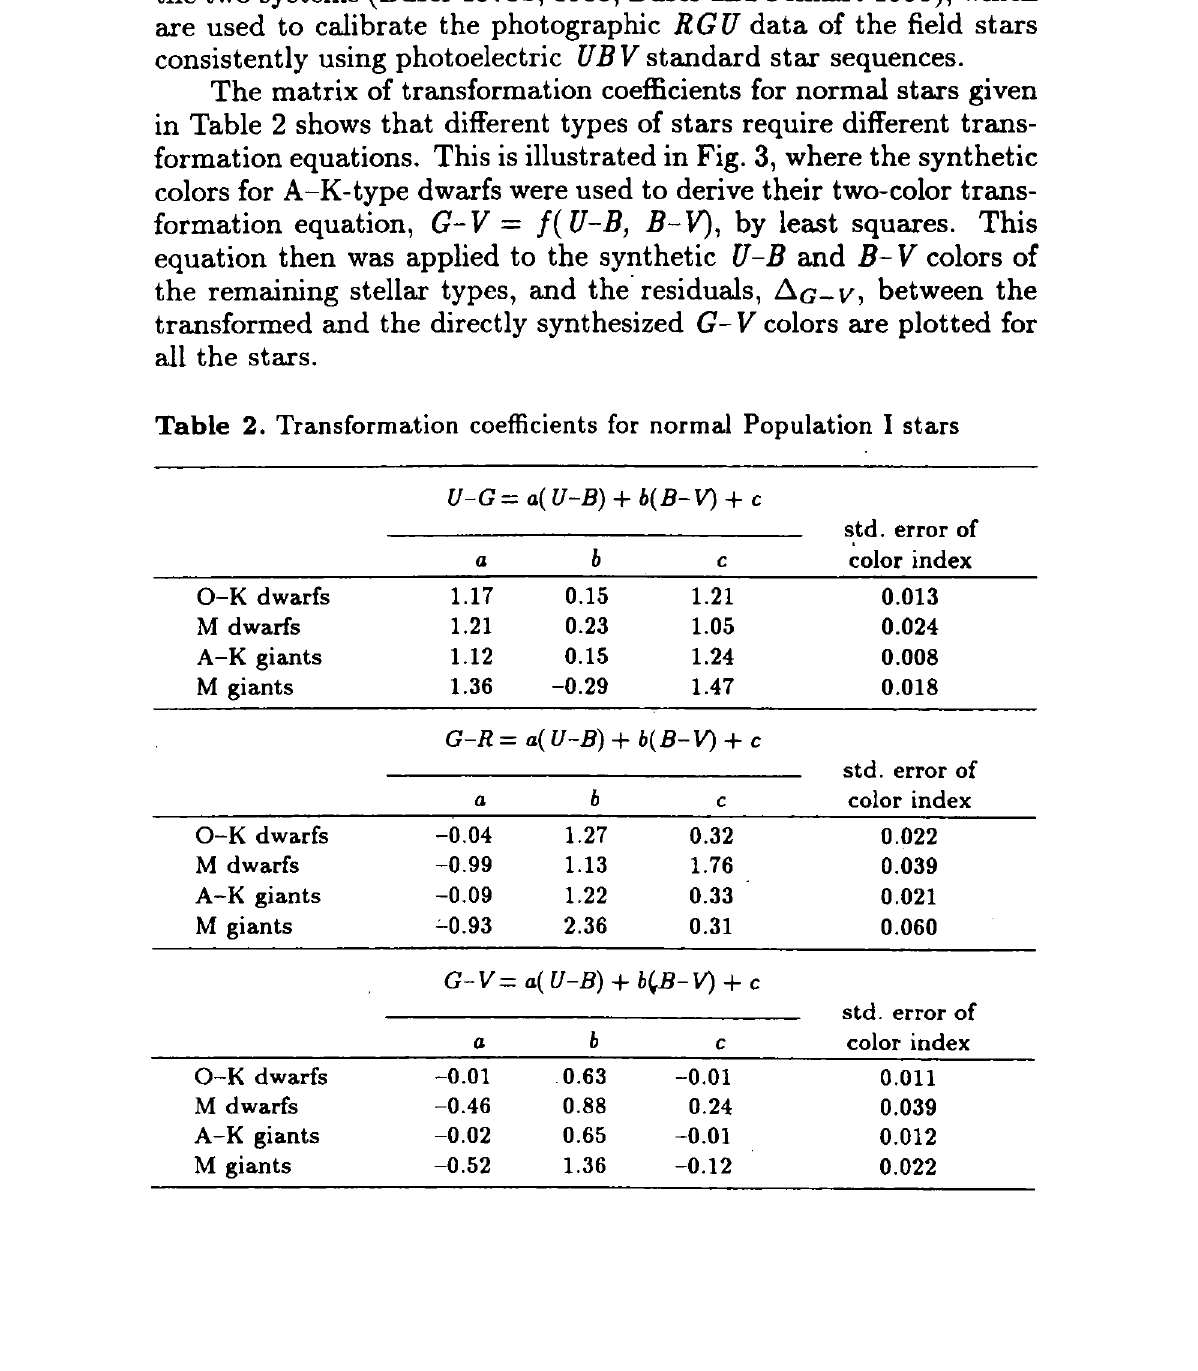
Table 2. Transformation coefficients for normal Population I